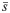
Asymmetric inhibition and elimination of bimodality and non-ergodicity.(A) Illustration of self-coupled network with additional asymmetric inhibitory feedback. Each neuron receives inhibitory input JI < 0 from the additional neuron whenever the population-average s¯ becomes greater than the inhibition threshold θ. (B) Population-averaged activities s¯(t) from several instances of the inhibited Glauber dynamics, with JI = −24.7, θ = 0.3, and homogeneous Jij = Jr, hi = hr of Eq (16), as used for Fig 4B. Each instance starts with an initial population activity s(0) having different values of the population average s¯(0), and is represented by a different grey shade, from Ns¯(0)=0 (light grey) to Ns¯(0)=N (black). Note the disappearance, thanks to inhibition, of the bistability that was evident in the “uninhibited” case of Fig 4B. (C) Analogous to panel B, with JI = −24.7, θ = 0.3, but inhomogeneous normally distributed couplings and biases as in the uninhibited case of Fig 5C. The bistability again disappears thanks to inhibition. (D) Comparison of a longer (5 × 106 timesteps) Glauber sampling in the inhibited (black, JI = −24.7, θ = 0.3) and uninhibited (red) case, using the couplings and biases of Fig 2D obtained from our first Boltzmann learning. (E) Time averages mi and gij obtained from Boltzmann learning for the inhibited model Pi, versus experimental ones. (F) Probability distribution of the population-averaged activity Pi(s¯) given by the inhibited model Eq (22) for our dataset Eq (15), compared with the one previously given by the reduced model Pr(s¯), Fig 4A.